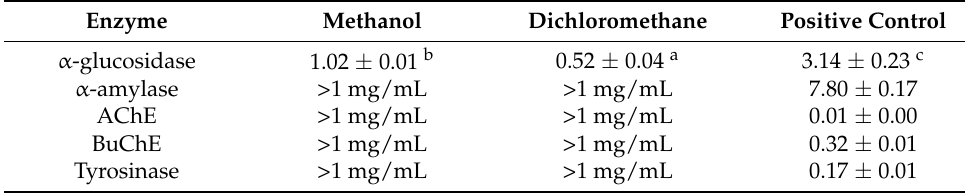
Table 3. Enzyme inhibitory activities of the methanol and dichloromethane extracts of the aerial parts of sea heath ( F. laevis ). The results are expressed as half-maximal effective concentration (EC 50 ) values (mg/mL).